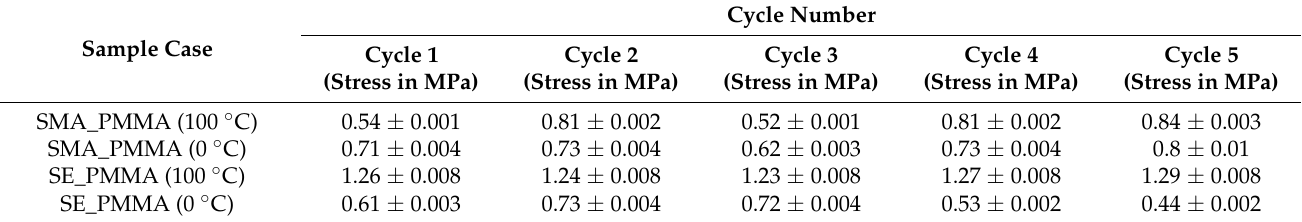
Table 3. Interlayer stress for various composites with PMMA at various cycles.